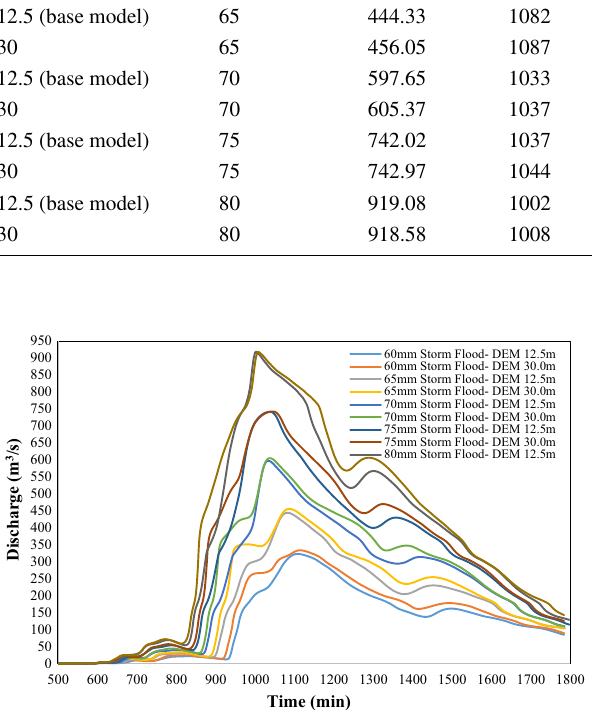
Fig. 14 Flood hydrographs of calibrated GSSHA base model for five 24-h floods of 60–80 mm cumulative storm depths compared to hydrographs corresponding to GSSHA model of 30 m resolution DEM